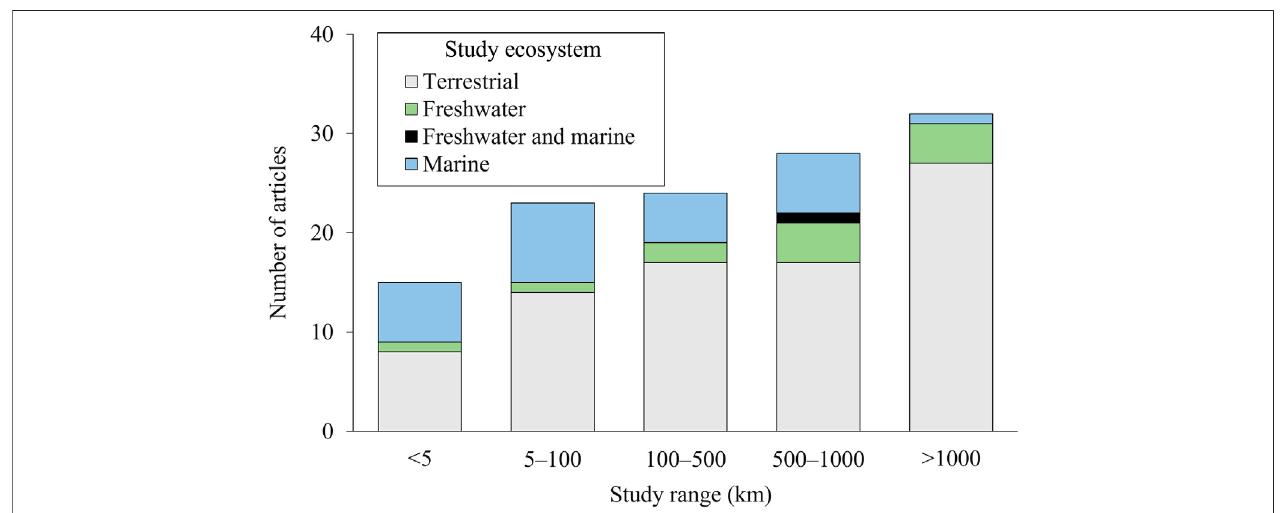
FIGURE2| Studyrangeofarticlespublishedoncitizenscienceandnon-indigenousspeciesaccordingtofourecosystemcategories(terrestrial,freshwater,freshwater and marine, marine). A total of 122 studies reported information on this issue. Data were retrieved from a bibliographic survey made in July 2019 with SCOPUS using a combination of keywords: “ invasive species ” and “ citizen science ” , “ non-indigenous species ” and “ citizen science ” , and “ non-native species ” and “ citizen science ” .